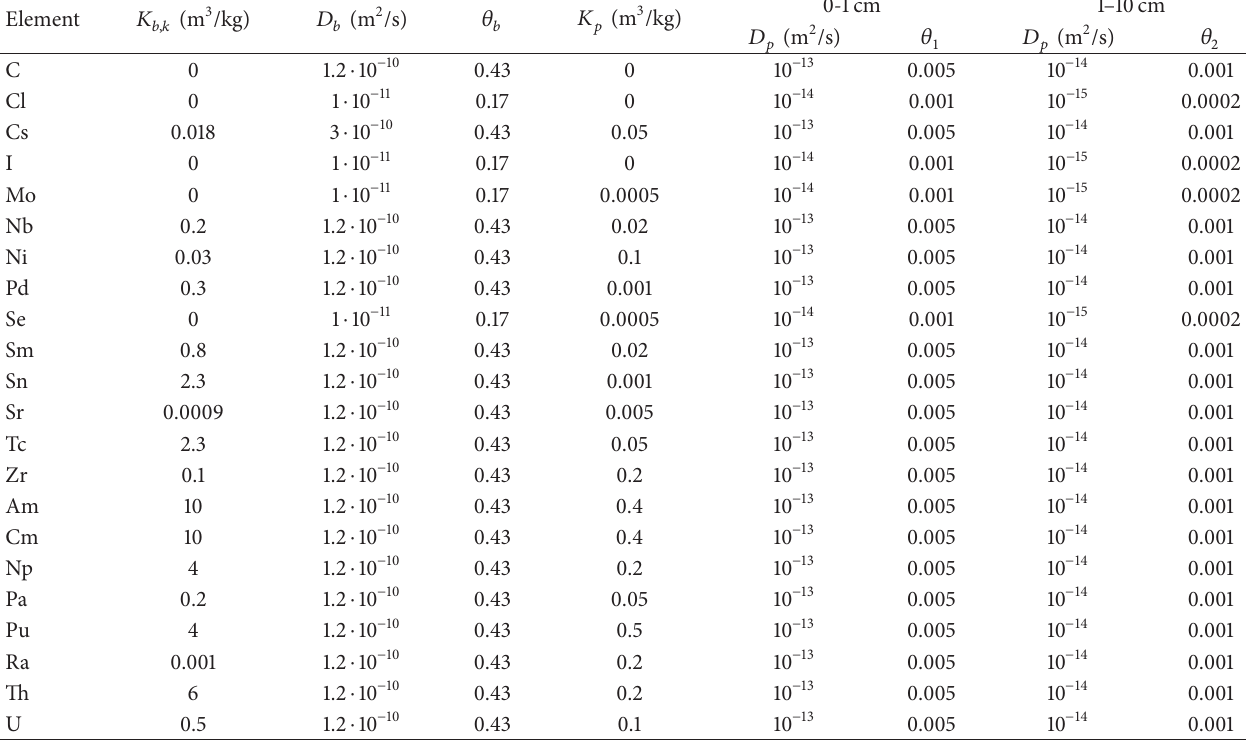
Table 2: Physical parameters for elements in this study: distribution coefficient in the bentonite ( 𝐾 𝑏,𝑘 ), bentonite diffusion coefficient ( 𝐷 𝑏 ), bentonite porosity ( 𝜃 𝑏 ), distribution coefficient in the rock matrix ( 𝐾 𝑝,𝑘 ), pore diffusion coefficient ( 𝐷 𝑝 ), and porosity of the rock matrix ( 𝜃 ). Element